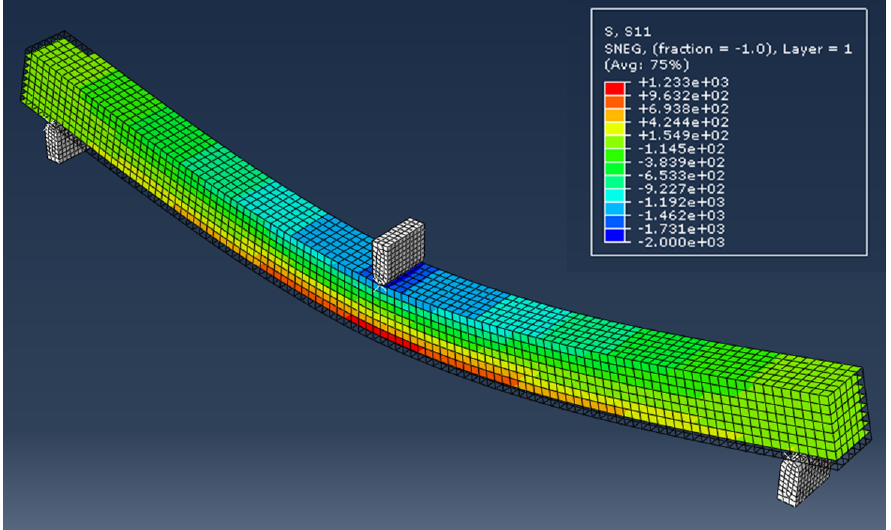
Figure 9. Three-point bending analysis of the